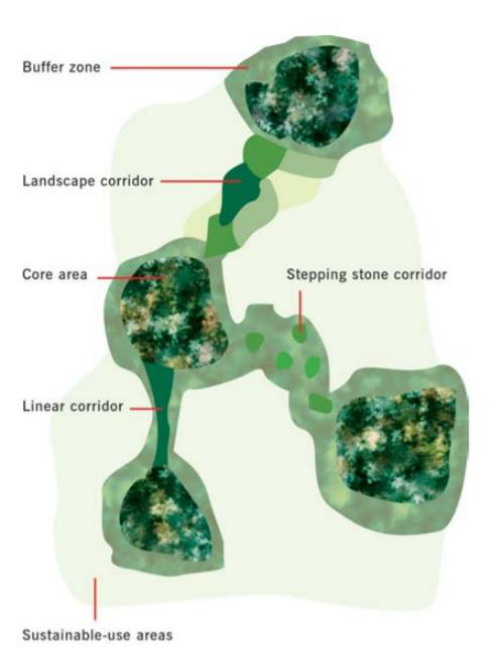
Figure 1. Components of ecological network (Bennett, 2004) Green roofs are argued to enhance and support the biodiversity, and they can be highly effective if they are included in an ecological network (Joimel et al., 2018). Green roofs